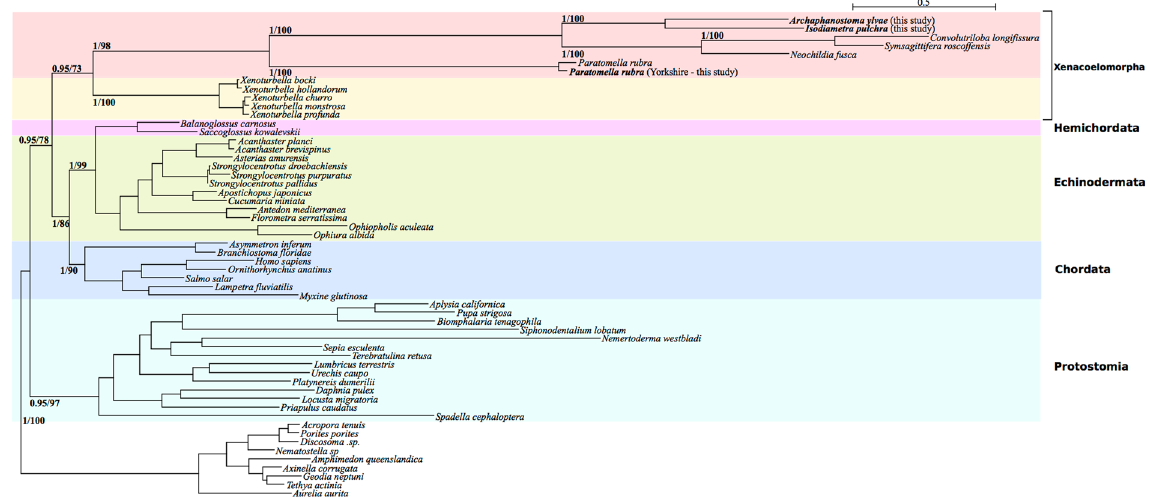
Figure 7. Bayesian (using PhyloBayes 53 ) and Maximum Likelihood (using RAxML 51 ) phylogenetic analysis of mitochondrial protein-coding genes from the Metazoa, including P. rubra , I. pulchra and A. ylvae with posterior probability and bootstrap support values, respectively, at relevant nodes. Analysis carried out on trimmed alignment. Topology of both trees is